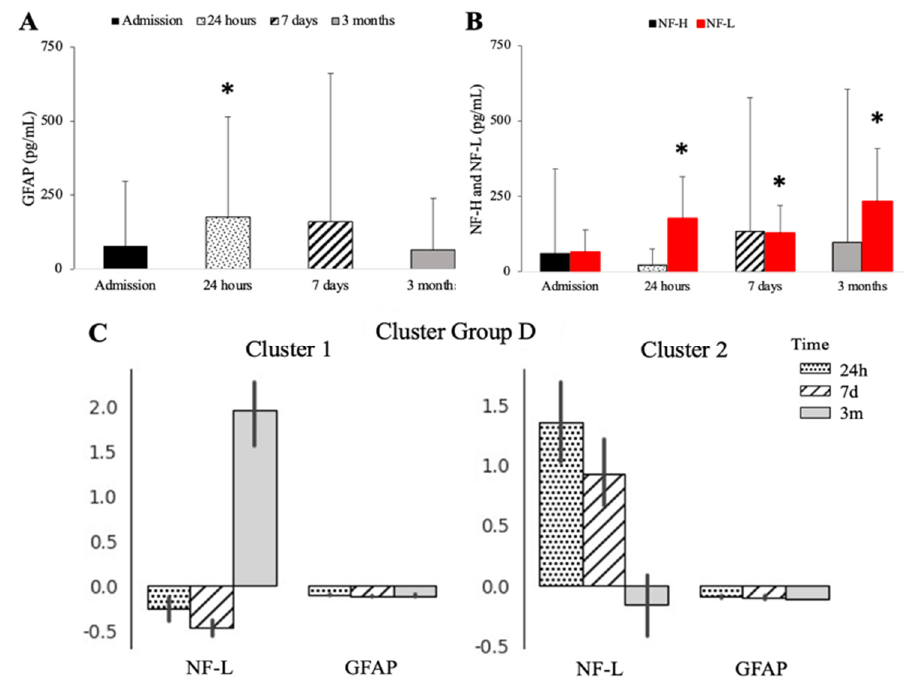
Figure 2. Post-operative changes in neuroinjury markers. Levels of GFAP ( A ), NF-H ( B , grey bars), and NF-L ( B , red bars) at baseline, 24 h, 7 days, and 3 months. ( C ) Cluster analyses separated by levels of NF-L and GFAP at 24 h (dots), 7 days (striped bar), and 3 months (solid bar). * p < 0.05.